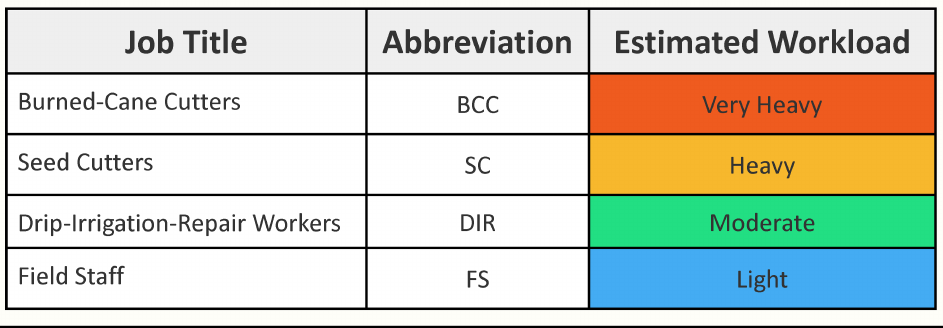
Figure 1. Job Categories and their Harvest 1 estimated